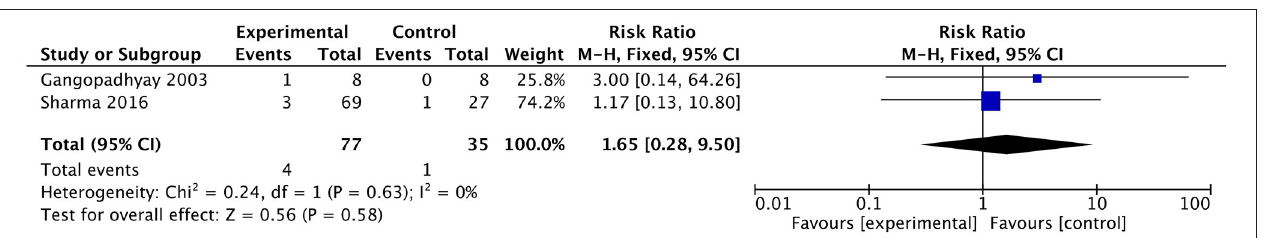
anatomical presentations and associated malformation.